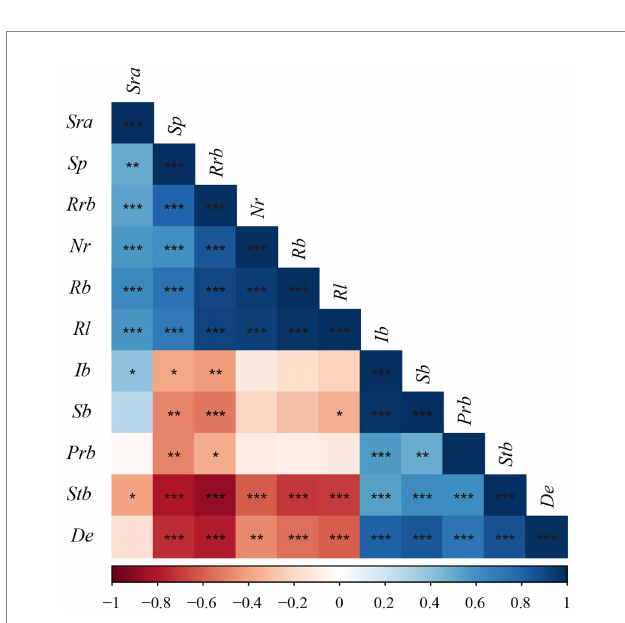
FIGURE 4 Pearson correlation among reproductive characteristics of D. angustifolia . Rl , rhizome length per plant; Nr , number of rhizome buds per plant; Sp , spacer; Rrb , proportion of rhizome bud; Rb , rhizome biomass per plant; Stb , tiller node bud per plant; Sra , sexual reproduction allocation; De , density; Prb , population rhizome biomass; Ib , inflorescence biomass; Sb , sexual plant biomass. * indicate the level of correlation, * p < 0.05; ** p < 0.01; *** p < 0.001.